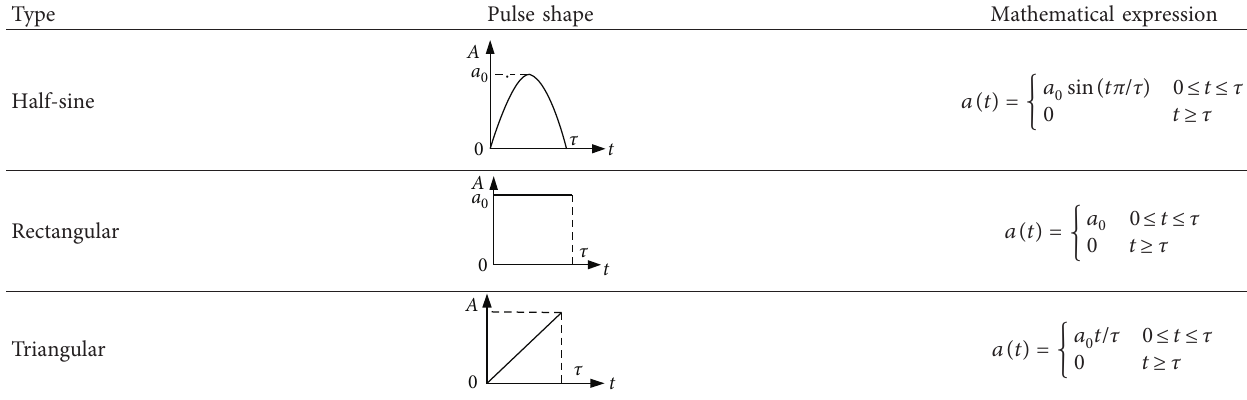
Table 1: Mathematical expressions of acceleration